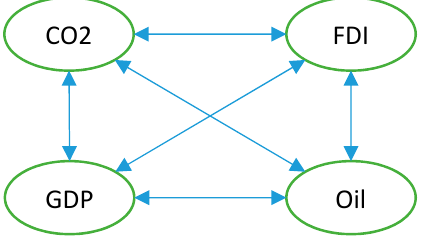
Figure A2. Summary of long ‐ run Granger causality test.